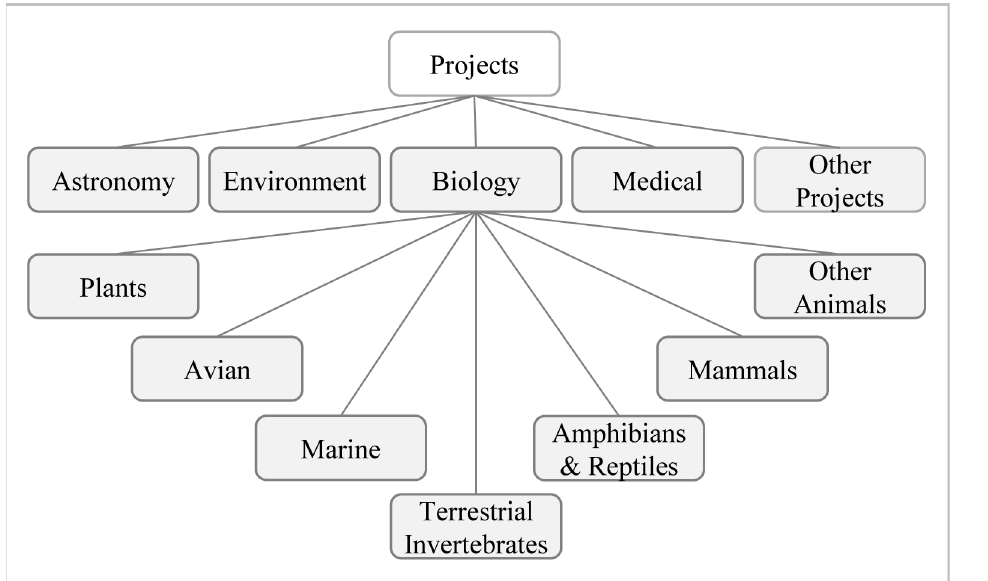
Fig 2. Categorization of citizen science projects into topics.